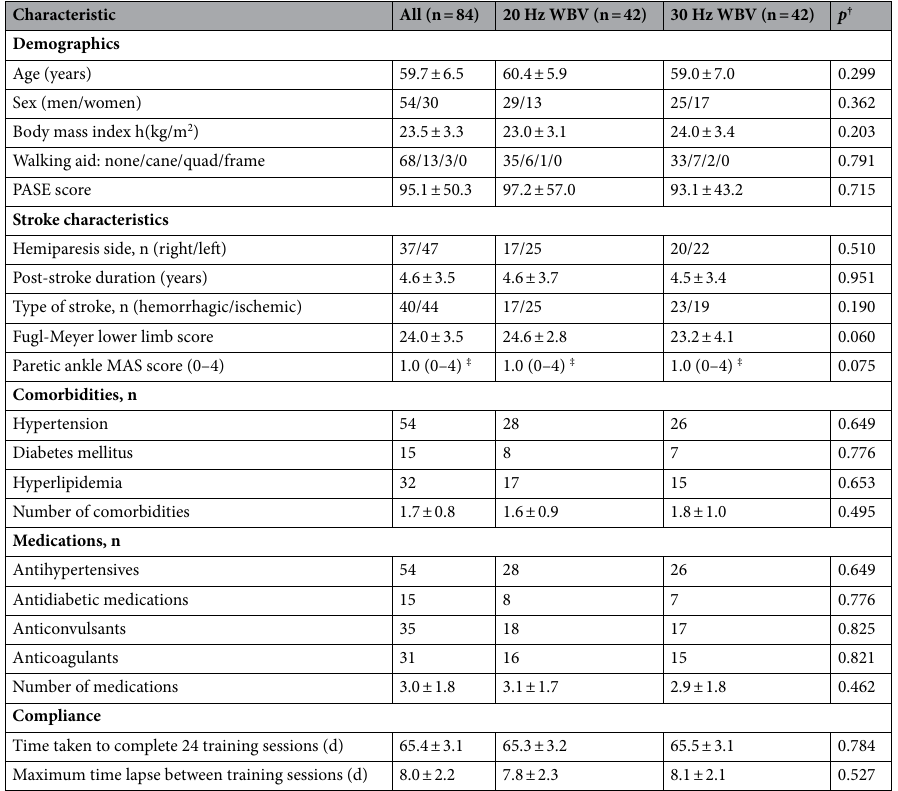
Table 1. Participant characteristics at baseline * . *Mean ± standard deviation presented unless indicated otherwise. † Between-group comparison. ‡ Median (interquartile range). Abbreviations: 20 Hz WBV: 20 Hz whole-body-vibration group, 30 Hz WBV: 30 Hz whole-body-vibration group, PASE: Physical Activity Scale for the Elderly, MAS: Modified Ashworth